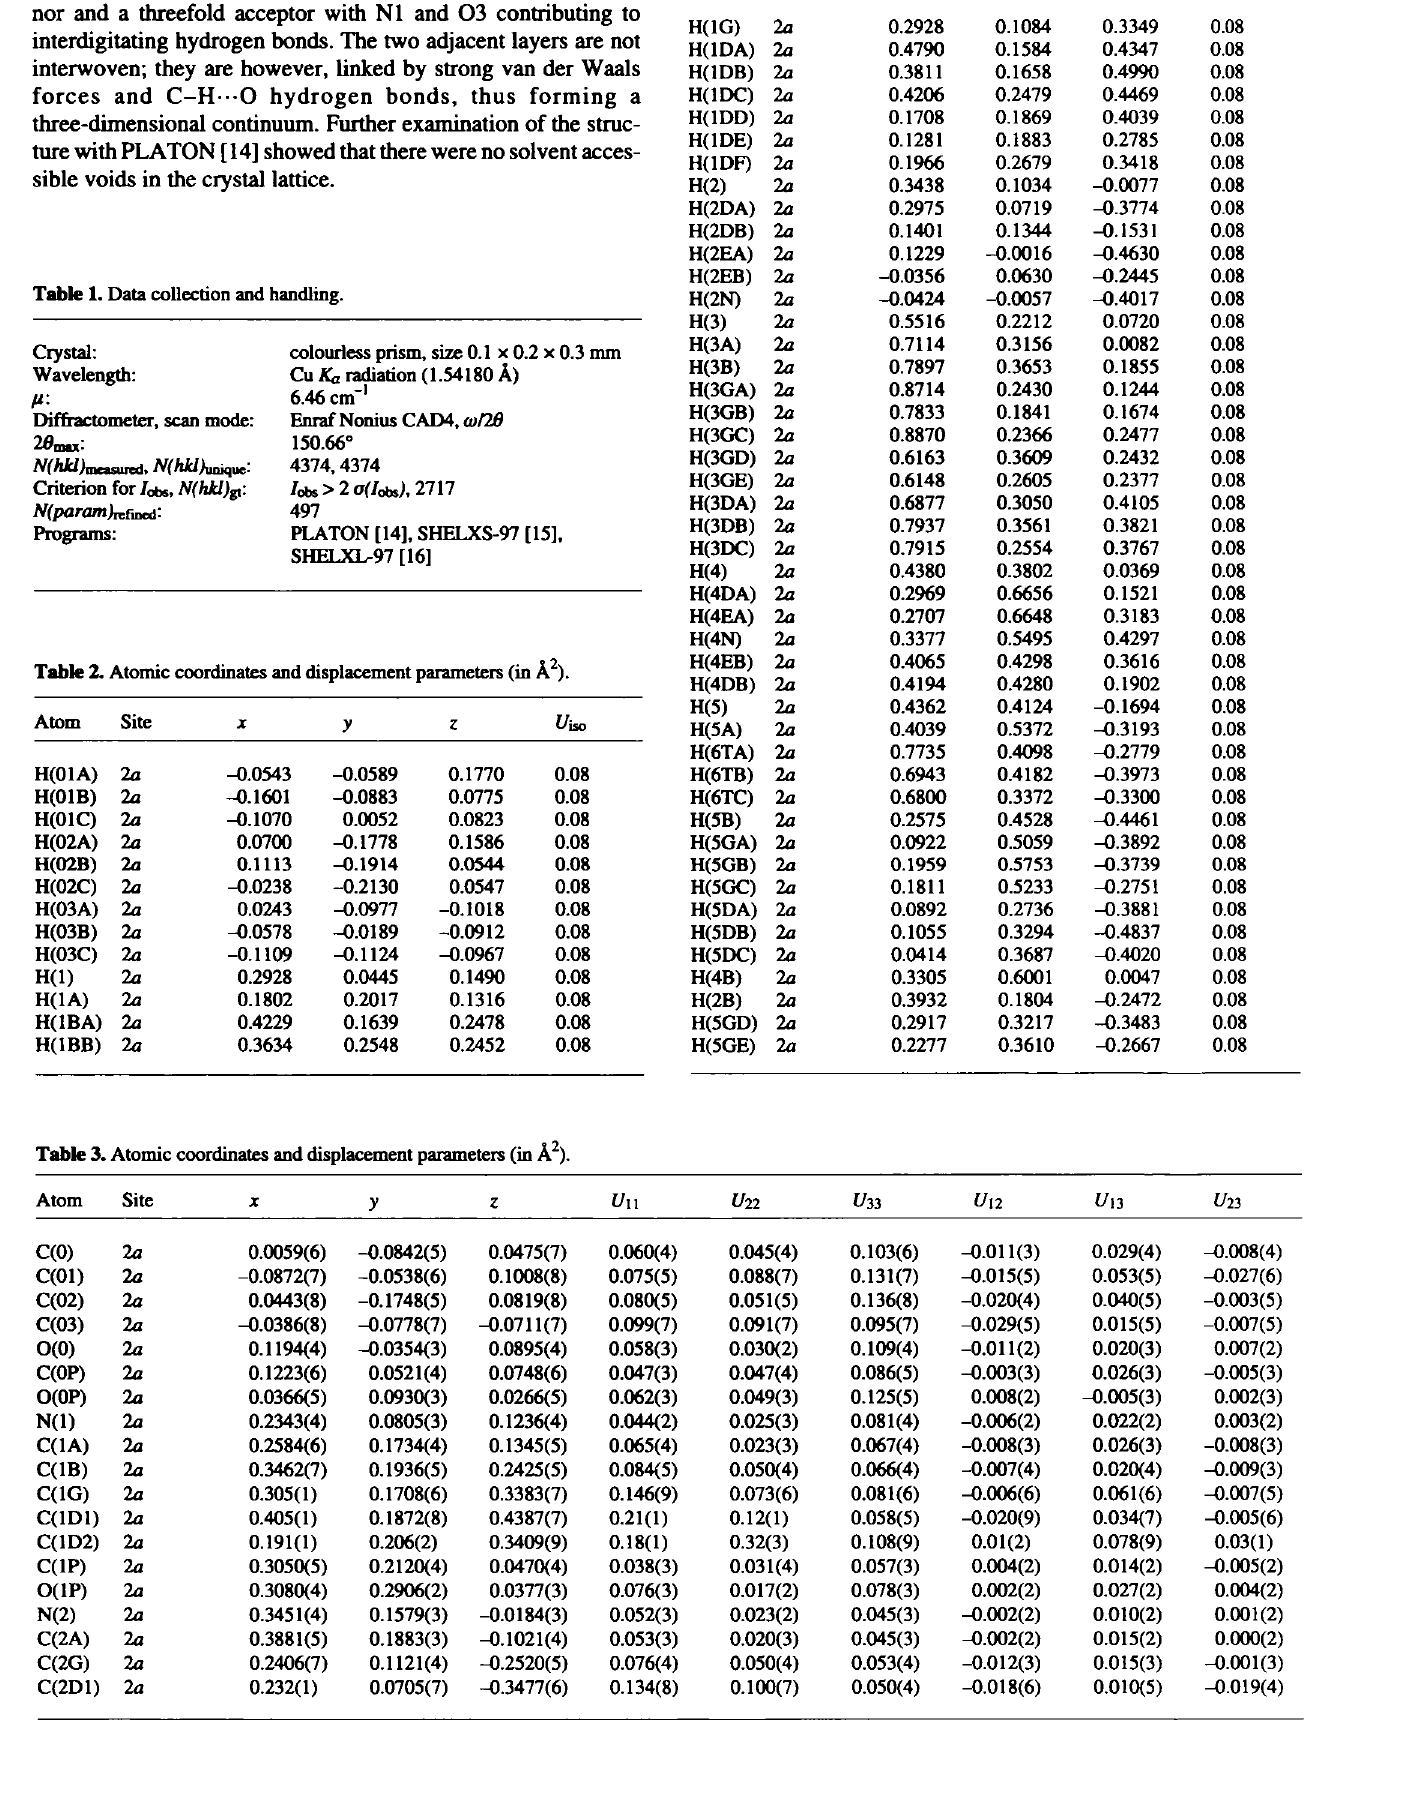
Table 2. Atomic coordinates and displacement parameters (in Â 2 ).